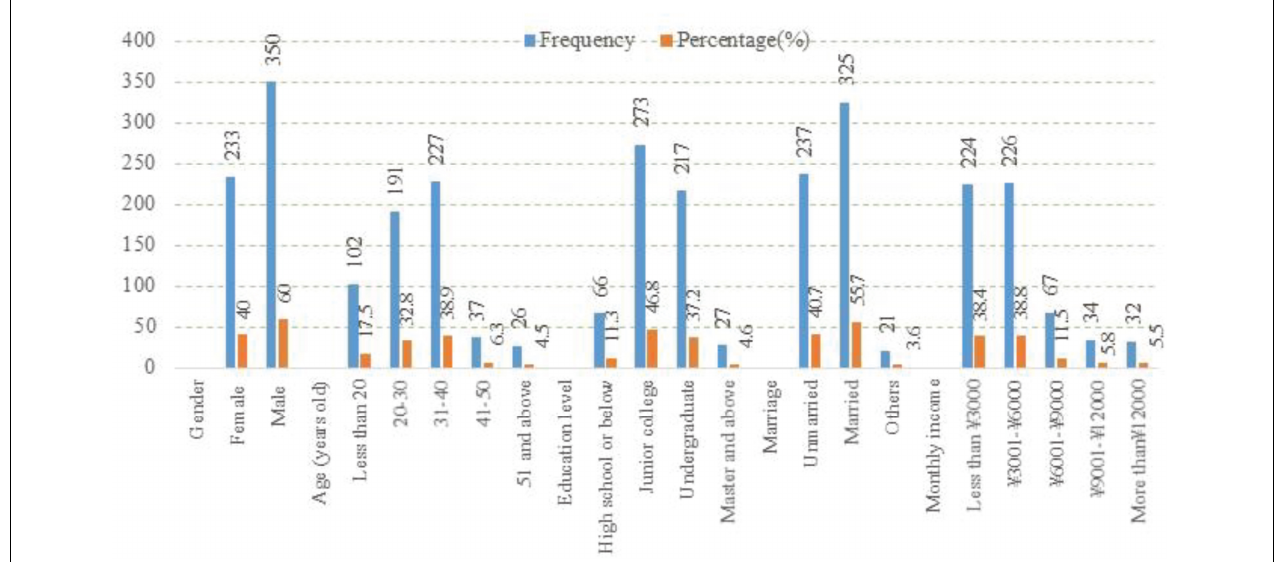
FIGURE 2 | Respondent demographics ( N =